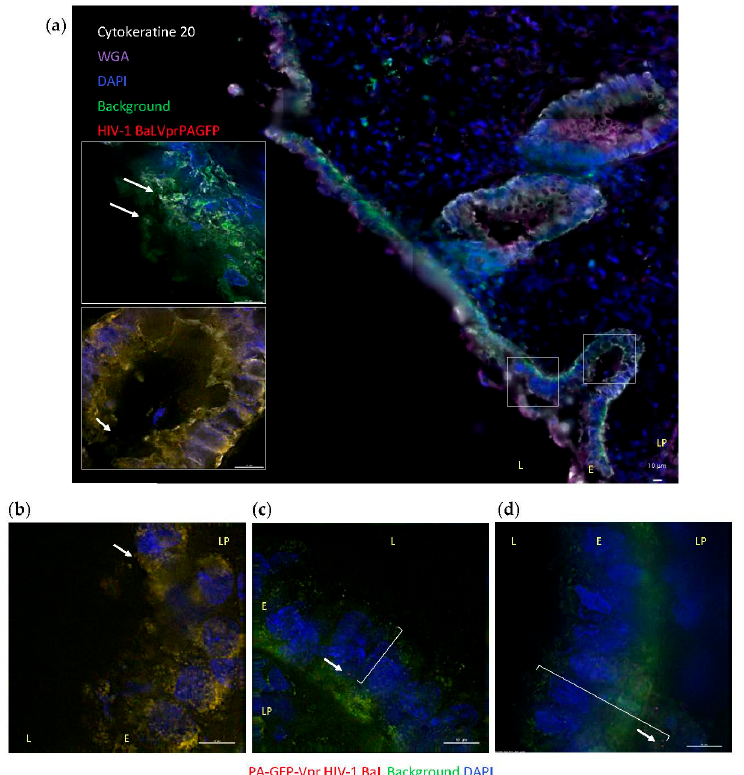
Figure 2. Ex vivo HIV-1 interactions with human colorectal tissue. Colorectal explants were exposed to PA-GFP-Vpr HIV-1 BaL (red and signaled with arrows) for 6 h. ( a ) Representative image of cryosections stained with cytokeratine 20-RedX (white) and WGA-Cy5 (purple) to label the columnar epithelium; autofluorescence is shown in green; top and bottom insets correspond to left and right boxed areas in main image, respectively. ( b – d ) Representative images of cryosections with autofluorescence shown in green; brackets indicate distance of virion from the tissue surface: ( c ) 18.6 µ m and ( d ) 39 μ m. Cell nuclei stained with DAPI (blue). White bar = 10 μ m. L: lumen; E: epithelium; LP: lamina propia.